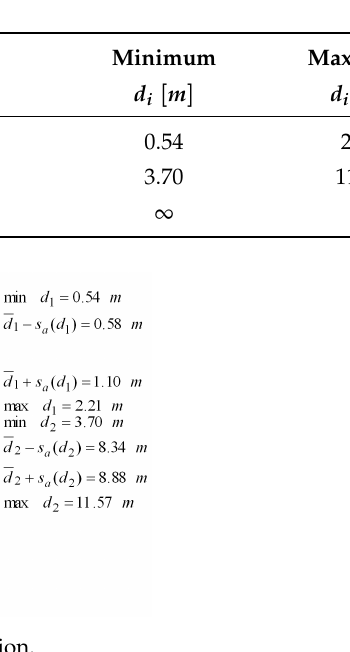
Table 11. Depth values (mean, minimum, maximum, and standard deviation) until limitation of several layers.